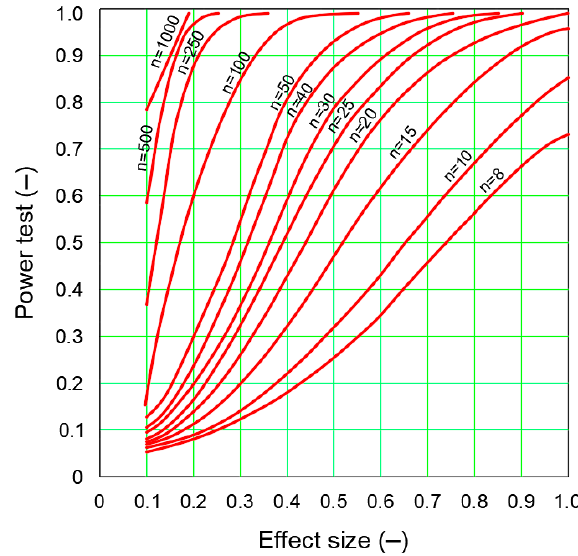
Figure 6. Examples of test power curves. Own study based on: [48].